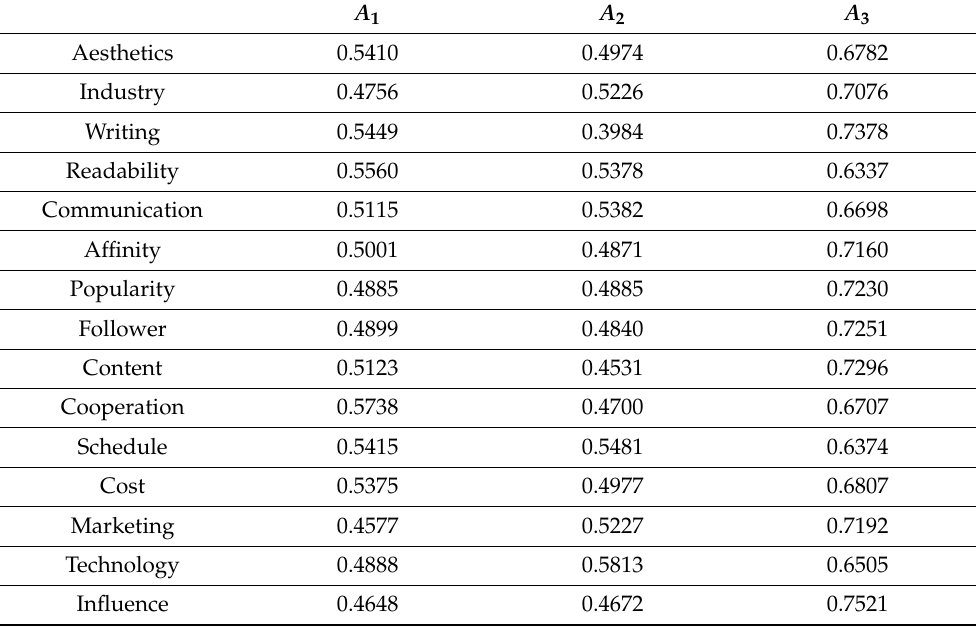
Table 6. The normalized evaluation value.